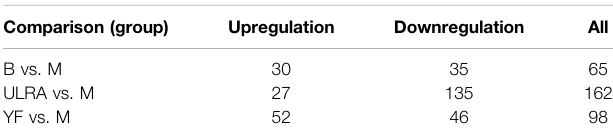
TABLE 4 | Protein expression results. Comparison (group) Upregulation